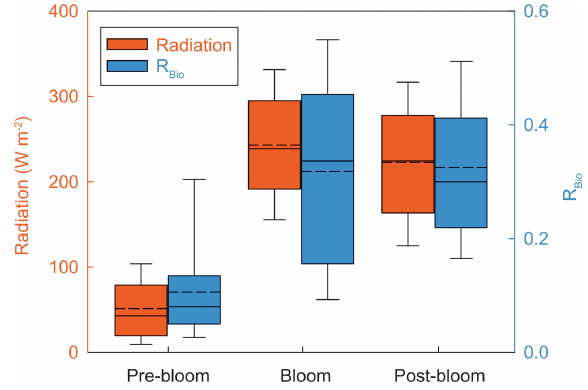
Figure 7. Five-year (2015, 2016, 2017, 2018, and 2019) mean radi- ation (red) and R Bio (blue) during the pre-bloom, bloom, and post- bloom periods. The solid line and dotted line represent median and mean value of each data in a box plot,